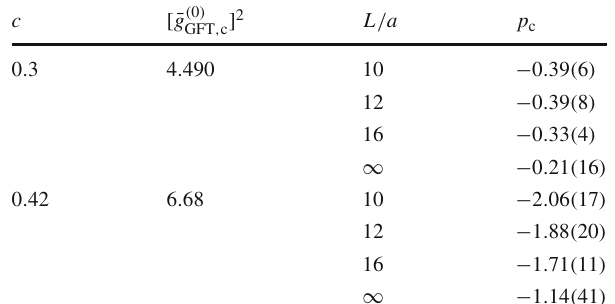
Table 8 Results for p c at finite lattice spacing (cf. Eq. (A.18)) obtained usingthevaluesforthe c t -derivativesoftheGFT-couplinginTable7and the1-loopapproximationfor Z b ,Eq.(A.16).Theresultsofa L / a → ∞ extrapolation linear in a / L are also given